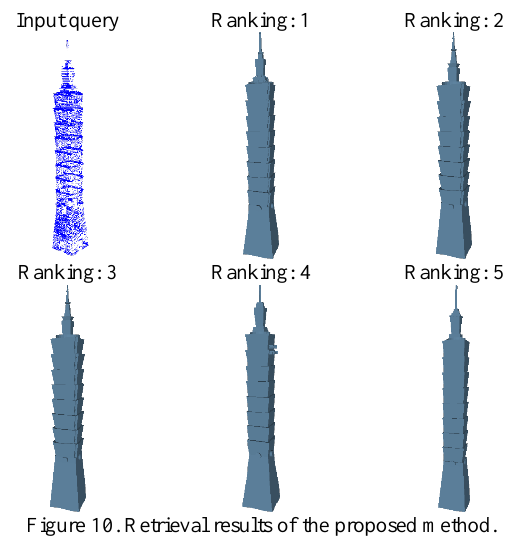
Figure 10. Retrieval results of the proposed method.